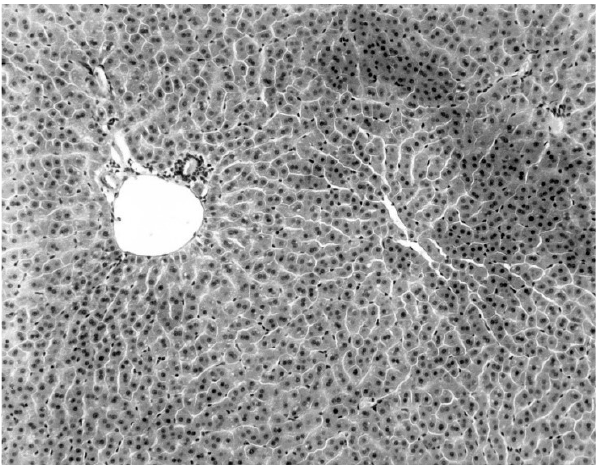
Figure 5. Liver section of a wrinkle-lipped free-tailed bat experimentally infected with KKV and harvested prior to day 5 post-infection, prior to when parenchymal cell destruction started occurring.